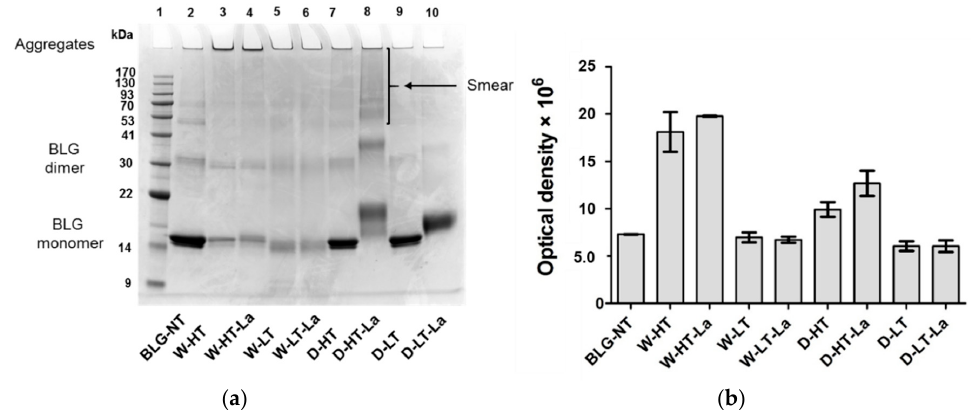
Figure 1. ( a ) Non-reducing SDS-PAGE image of soluble BLG heated and glycated in a wet system (W) and in a dry system (D), respectively in the absence of lactose or in the presence of lactose (La) and at either high temperatures (HT) or low temperatures (LT). ( b ) optical density of the aggregates visible in the top of each lane ( > 170 kDa). Error bars represent standard deviation of the optical density of two SDS-PAGE gels prepared independently from each